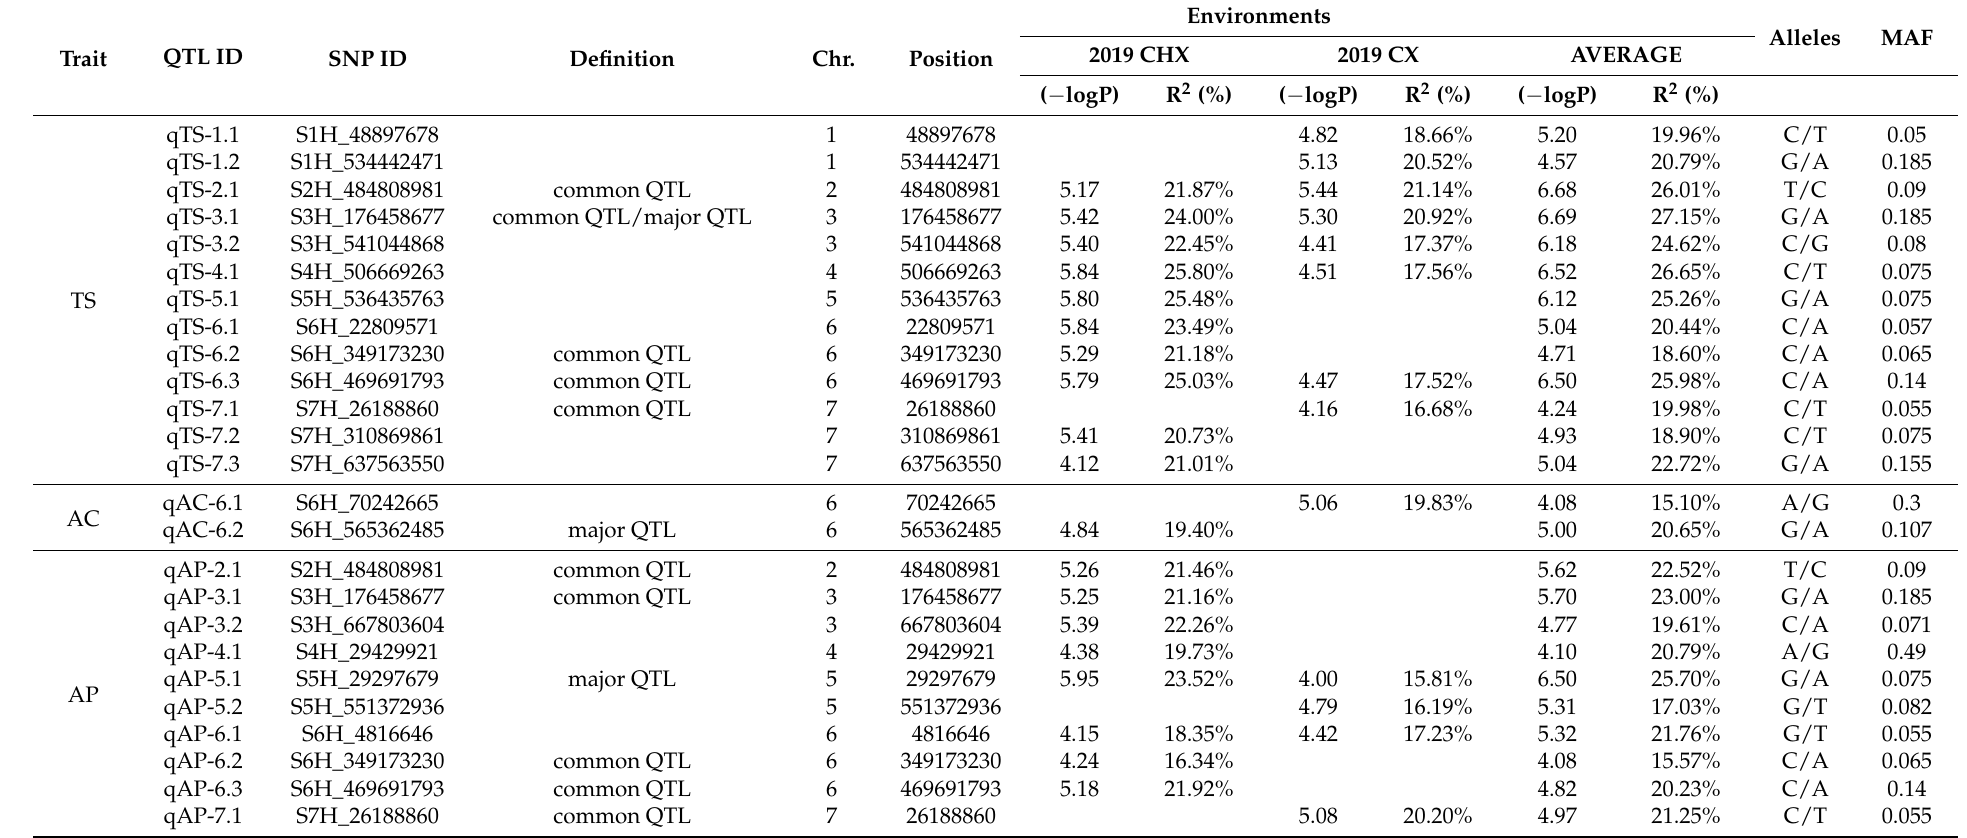
Table 2. The identified stable QTLs of TS, AC and AP in GWAS